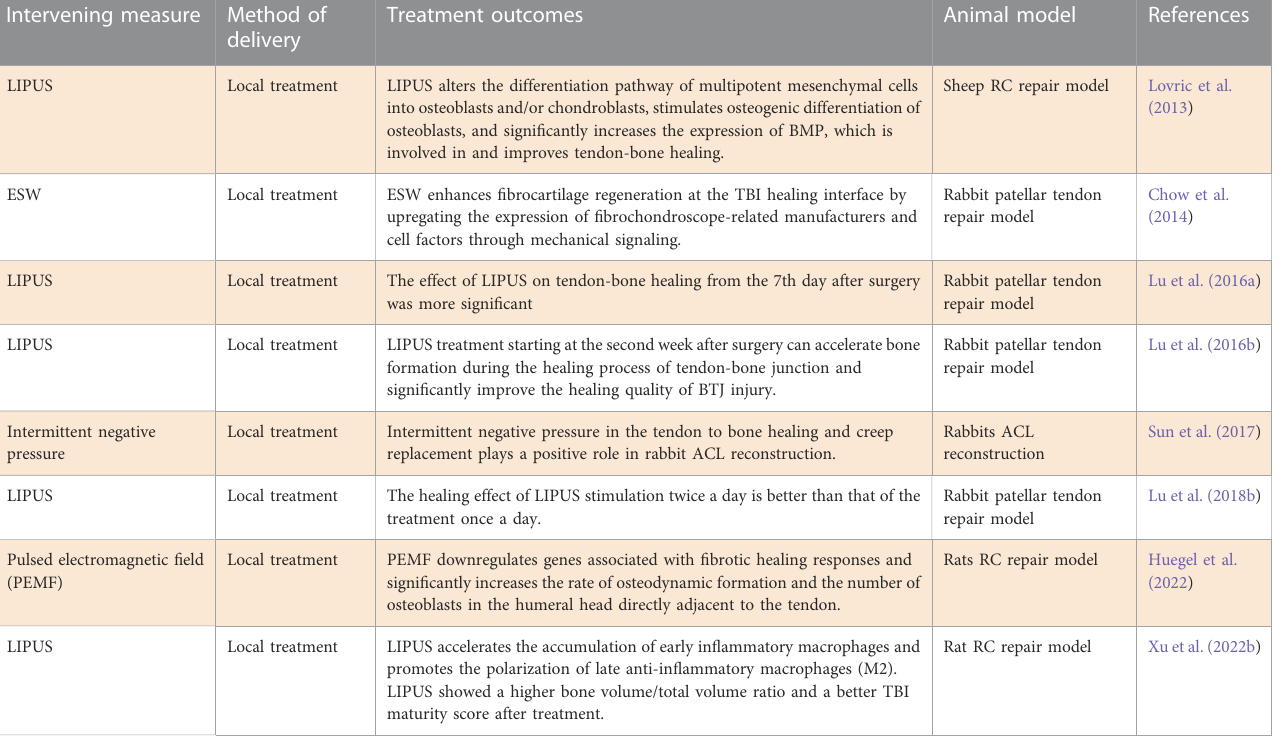
TABLE 6 Preclinical studies of physical therapy used to promote tendon-bone